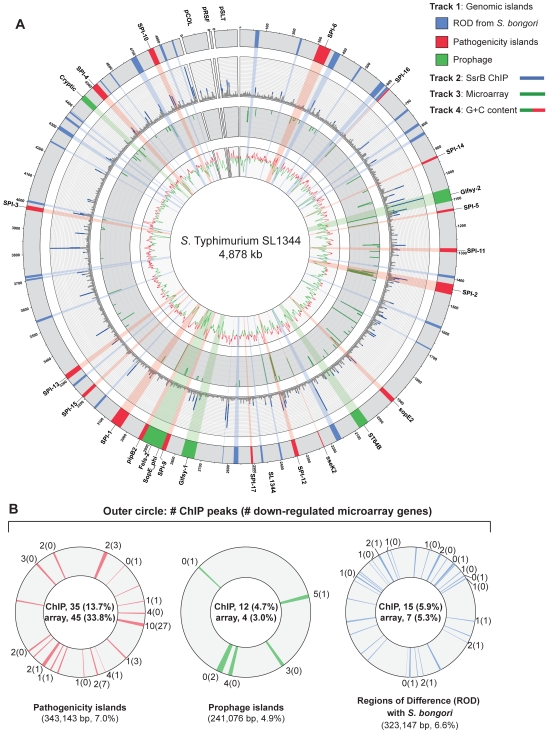
Genome-wide functional genomics analyses for SsrB.(A) ChIP-on-chip and microarray analysis. Genomic islands are indicated and labelled on track 1 (outermost circle), where prophages are in green, pathogenicity islands are in red and regions of difference (ROD) with S. bongori are in blue. ChIP-on-chip interaction scores (log2) for SsrB-activating conditions are plotted on track 2, where peaks with signals greater than one standard deviation from the mean probe signal are indicated in blue. Transcriptional profiling analysis of SsrB-regulated genes is plotted on track 3. Genes repressed more than 5-fold in an ssrB mutant are indicated in green. G+C content is plotted on track 4, where values greater than 53% (genome mean) are indicated in red and less than 53% are indicated in green. (B) Summary of gene expression data and SsrB binding data for pathogenicity islands, prophage islands, S. bongori ROD and genome sequence not in islands. The number of SsrB binding peaks identified by ChIP-on-chip for each of the individual islands is shown in the outermost track, along with the number of genes down-regulated in the transcriptional profiling analysis (in brackets). The total number of ChIP-on-chip interaction peaks and genes regulated by SsrB are shown in the innermost circles along with the percent of total (in brackets). The total genomic content of each island or conserved regions are shown below each circle, along with the percent of total genome. The remainder of microarray data (not in islands) includes 194 interaction peaks (75.8%) for ChIP-on-chip and 77 genes (58.0%) for transcriptional profiling arrays.